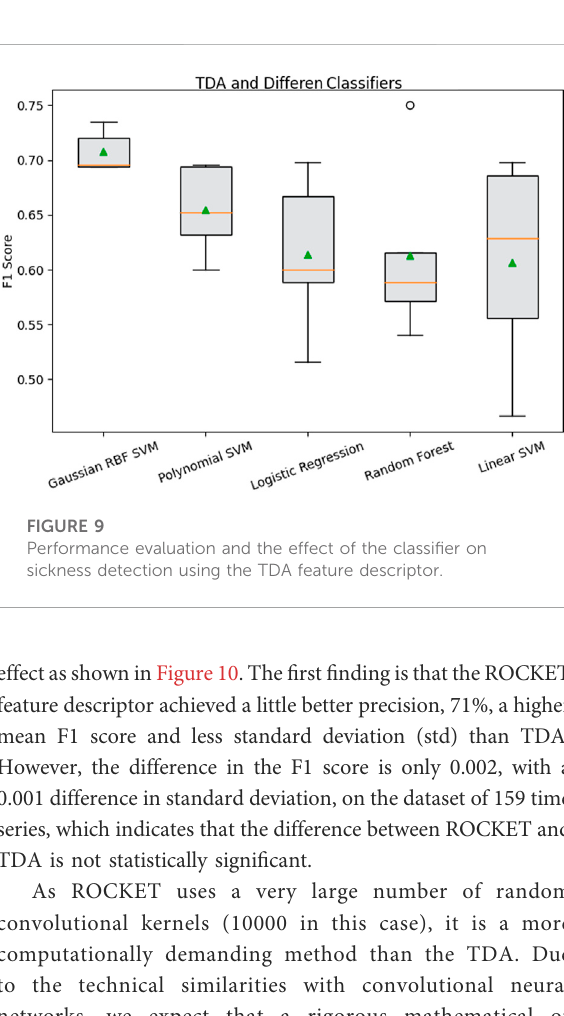
FIGURE 10 Performance evaluation using different feature extraction algorithms.